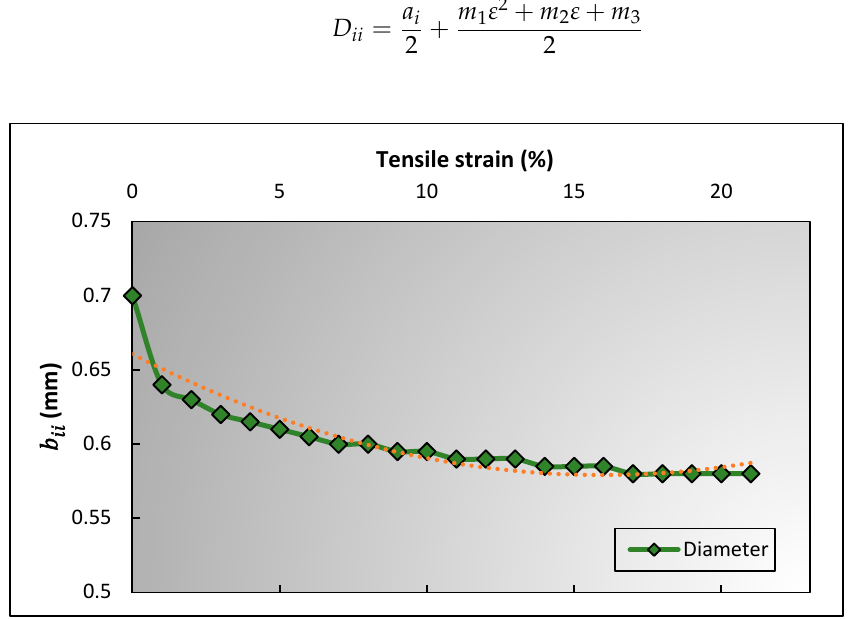
Figure 10. Trend of a diameter of warp yarn against tensile strain.